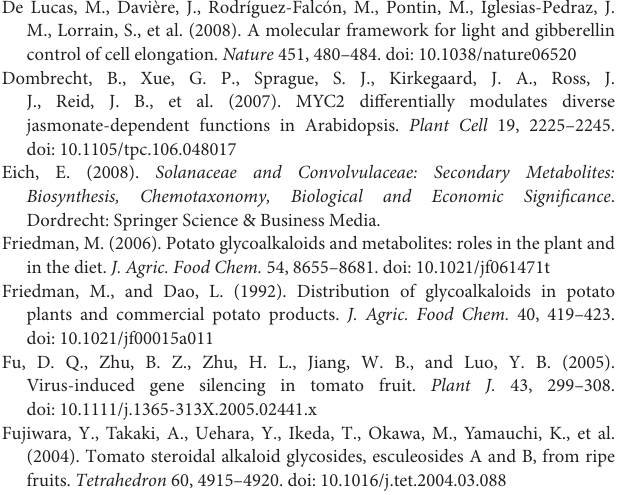
Figure S1 | Electrophoretic mobility-shift assays (EMSA) were conducted to validate the interaction of HY5 and PIF3 with the GAME1, GAME4, GAME17 promoters (not with GAME2, GAME6, GAME11, GAME12, GAME18 ).